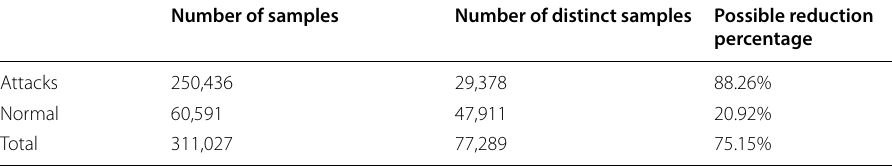
Table 3 Statistics about KDD testing set